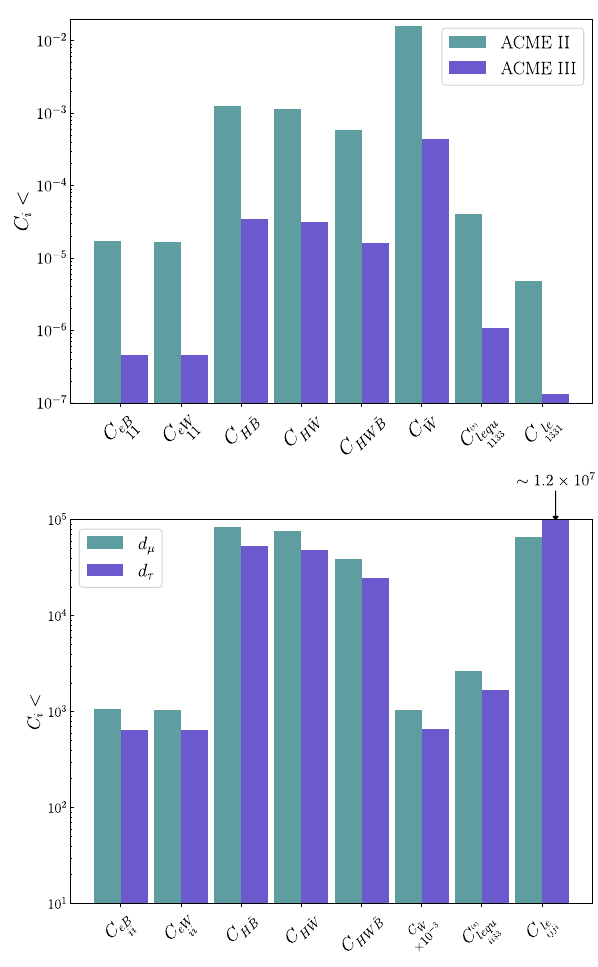
Fig. 5 Upper bounds on the Wilson coefficients, assuming (cid:2) = 5 TeV and applying the rescalings shown in Table 3, obtained including the full 1-loop expressions, from the experimental bounds on the different lepton EDMs. Upper panel: The current constraints (ACME II) coming from the best bounds on the electron EDM, compared to the ones from the projected future bounds (ACME III). Lower panel: We compare the boundsfromthetwoheavyleptonflavorswitheachother.Here i = 2 ( 3 ) stands for the muon (tau) EDM and j denotes the heavier of the two lepton flavors different from i in the operator O